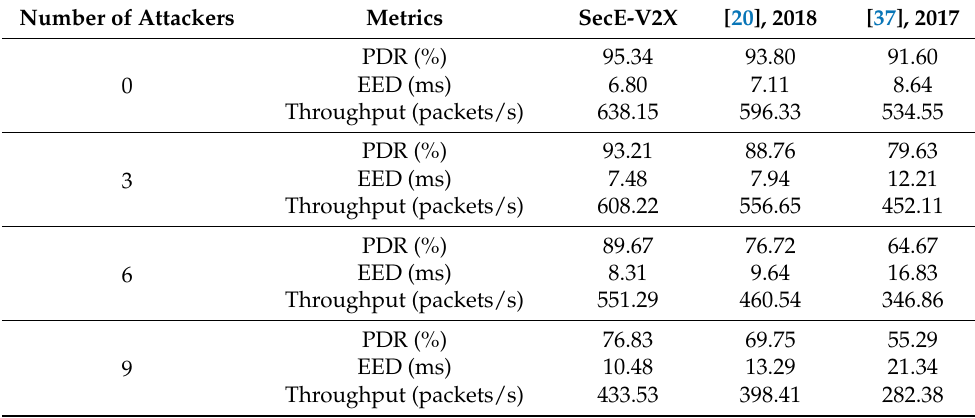
Table 5. Performance values comparison under Jellyfish periodic drop attacks.